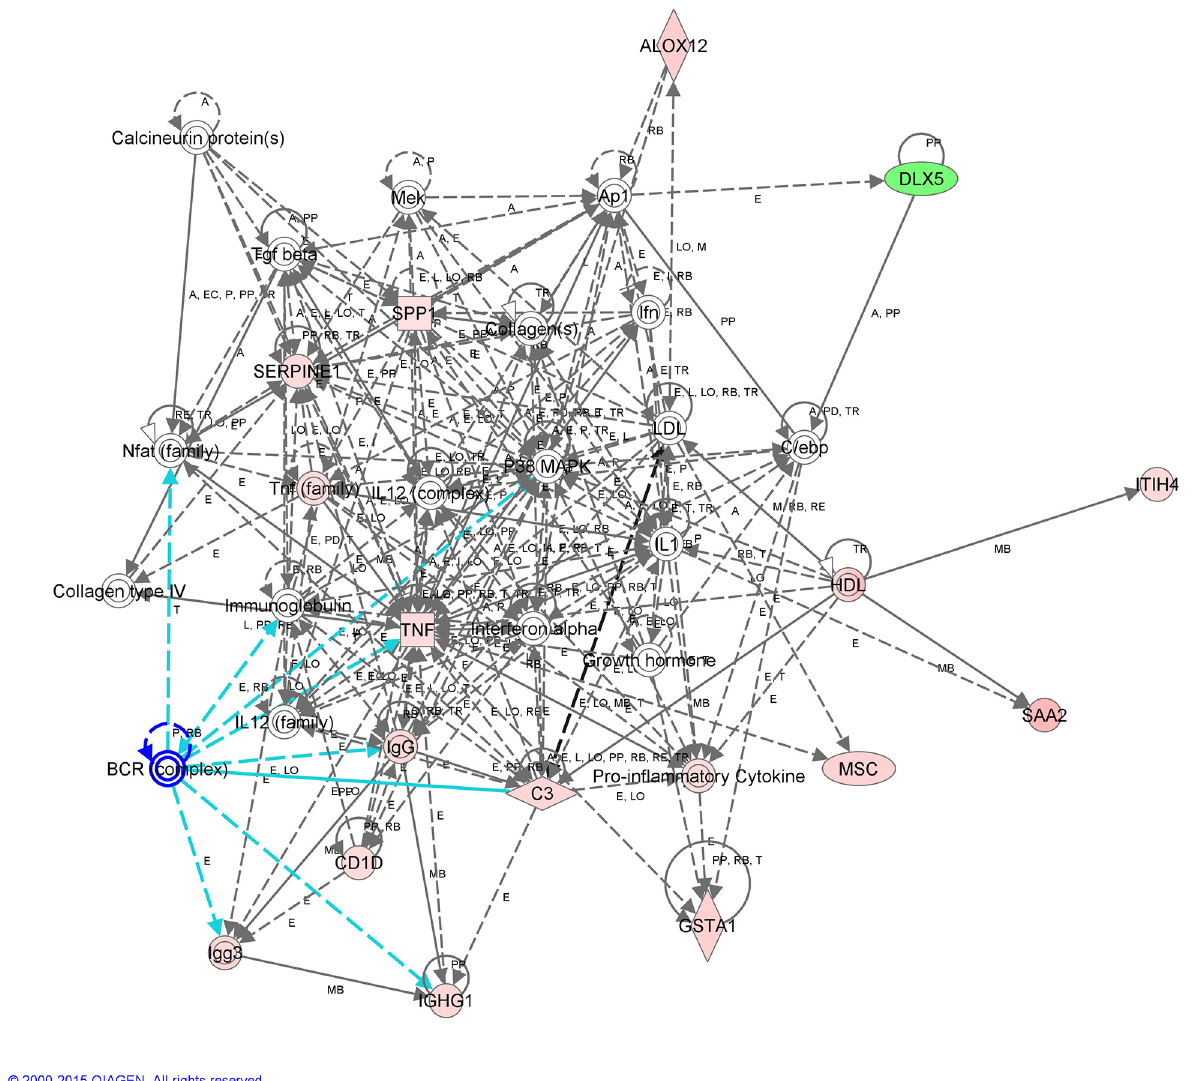
Fig 3. Interactome of functional associations among genes included in Network 1 by Ingenuity Pathway